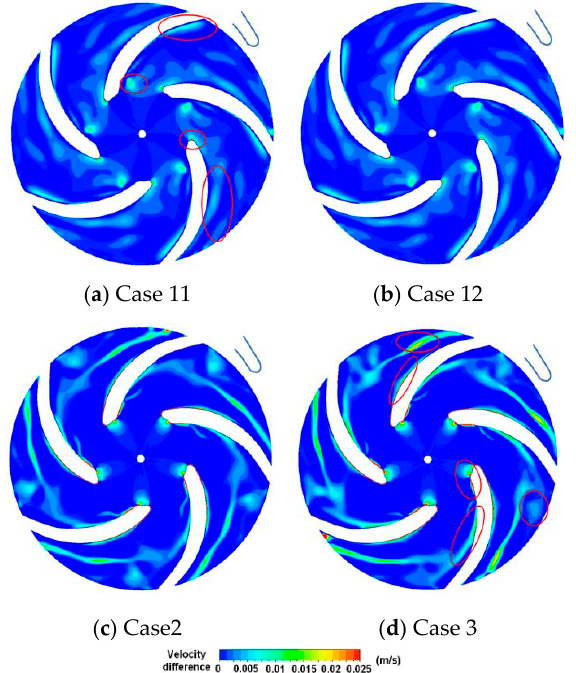
Figure 7. Distribution of velocity variation on the center plane of the increasing flow rate section.